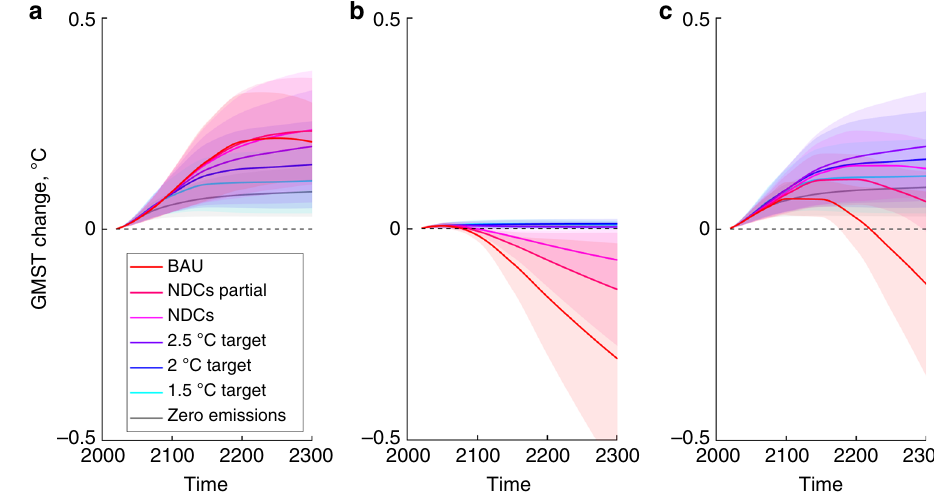
Fig. 4 Additional warming due to the nonlinear Arctic feedbacks relative to their legacy values. Differences between the GMST effects of the nonlinear PCF and SAF, and the GMST effects of their constant legacy values, obtained using the new PCF and SAF emulators in PAGE-ICE for a PCF, b SAF and c combined PCF & SAF. The legacy PCF value is zero and the legacy SAF value is the black dashed line in Fig. 2. Thick lines: ensemble mean; shaded areas: ±1SD. The cases when the GMST effect of the feedbacks is not signi fi cant at the 5% level: SAF under NDCs and NDCs Partial at the turn of the 22nd century, SAF under BaU in the second half of the 21st century, PCF & SAF combined under NDCs Partial in the second half of the 23rd century, and PCF & SAF combined under BaU from the second half of the 22nd century onwards. Source data are provided as a Source Data fi